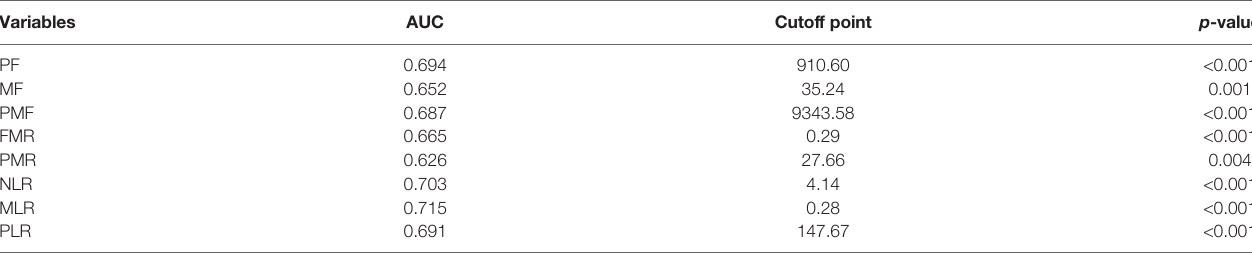
PF, platelet count* fi brinogen; MF, mean platelet volume* fi brinogen; PMF, platelet count*mean platelet volume* fi brinogen; FMR, fi brinogen-to-mean platelet volume ratio; PMR, platelet count-to-mean platelet volume ratio; NLR, neutrophil count-to-lymphocyte count ratio; MLR, monocyte count-to-lymphocyte count ratio; PLR, platelet count-to-lymphocyte count ratio; AUC, area under the